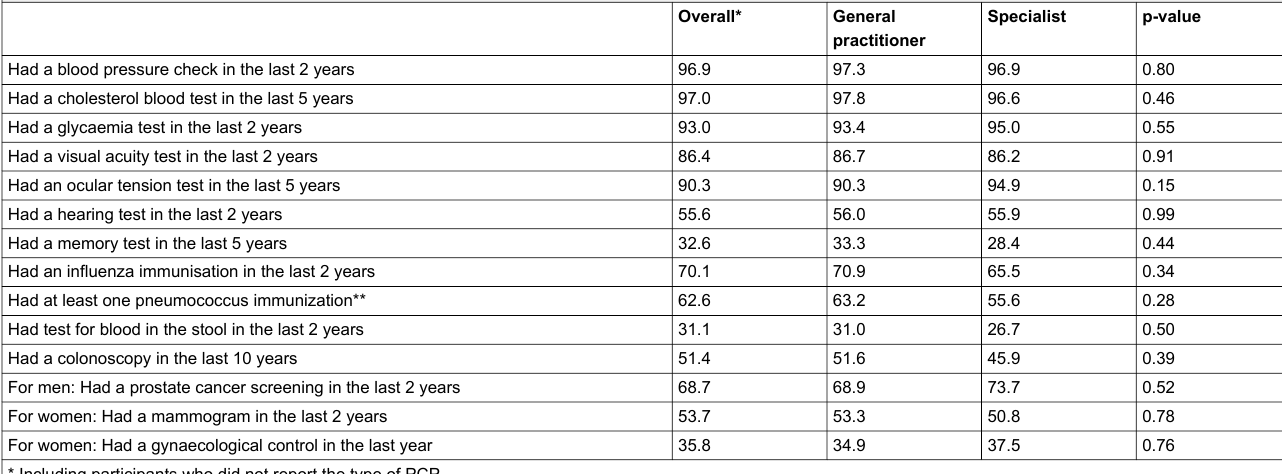
Table 4: Outcome – reported preventive tests, checks, and vaccinations, by type of primary care physician (all data presented as %, missing values excluded).